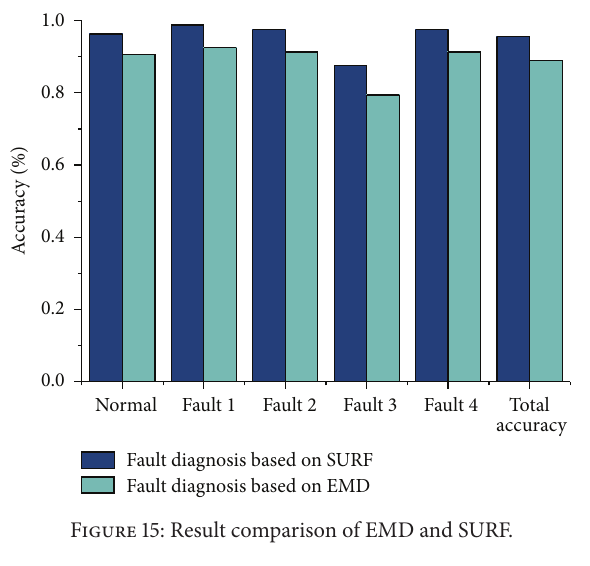
Figure 15: Result comparison of EMD and